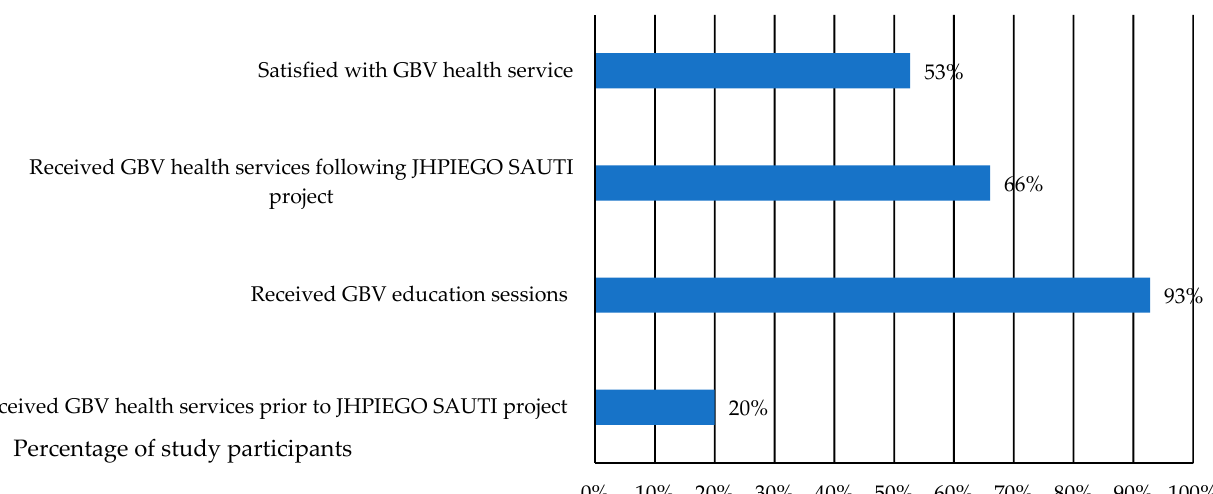
Figure 2. Access to GBV health services pre–and post– JHPIEGO SAUTI project implementation.